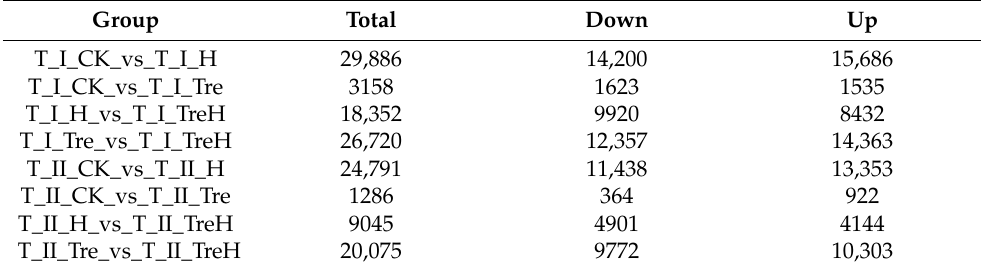
Table 1. Differential gene